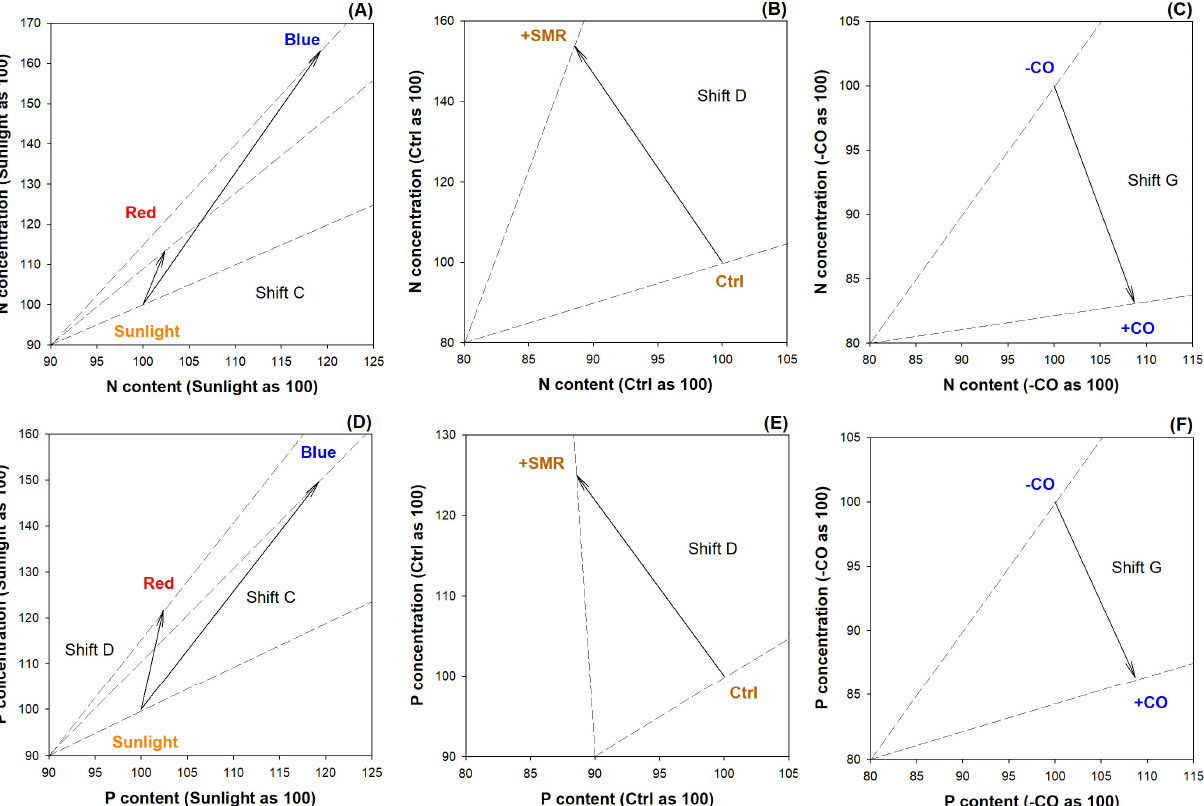
Figure 4. Vector diagnoses of leaf nitrogen (N) and phosphorus (P) statuses in black chokeberry ( Aronia melanocarpa (Michx.) Elliott 1821) exposed to separate light-type (sunlight, blue light-emitting diode (LED), red LED), chitosan oligosaccharide (CO), and spent mushroom residue (SMR) treatments: ( A ) diagnosis of leaf N status exposed to different light types; ( B ) diagnosis of leaf N status exposed to SMR amendment; ( C ) diagnosis of leaf N status exposed to CO addition; ( D ) diagnosis of leaf P status exposed to different light types; ( E ) diagnosis of leaf P status exposed to SMR amendment; ( F ) diagnosis of leaf P status exposed to CO addition. Abbreviations: Red, red light LED; Blue, blue light LED; +SMR, SMR amendment; Ctrl, no SMR amendment; -CO, no CO addition; +CO, with CO addition. Shifts and interpretations are adapted from Salifu and Timmer [75]: Shift C, nutrient deficiency; Shift D, luxury consumption; Shift G, nutrient